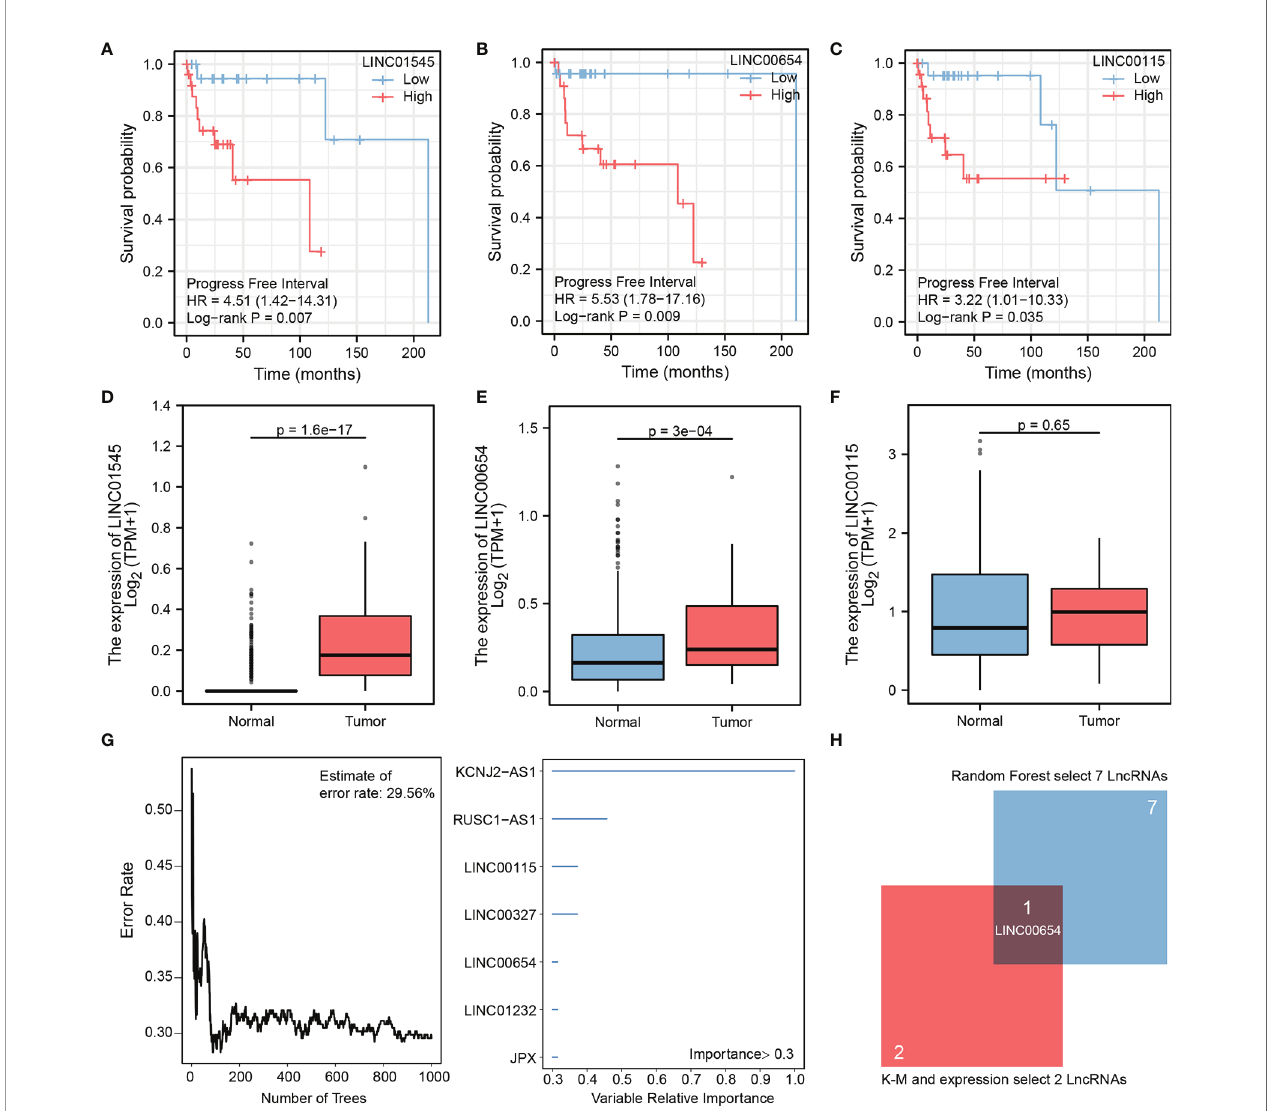
FIGURE 1 | Hub lncRNA-LINC00654 identi fi ed using the public database. Batch Cox regression was performed to screen for independent risk lncRNAs, TOP three lncRNAs (lnc01545, lnc00654, and lnc00115) are selected (A – C) , expression validation of three lncRNAs in TCGA database, two candidate lncRNAs were identify (lnc01545 and lnc00654) (D – F) , random forest model was used to select important lncRNAs, the model error rate was 29.56%, seven lncRNAs are listed (KCNJ2- AS1, RUSC1-AS1, lnc00115, lnc00327, lnc00654, lnc01232, and JPX) (G, H) the Venn diagram shows that lnc00654 was identi fi ed as hub